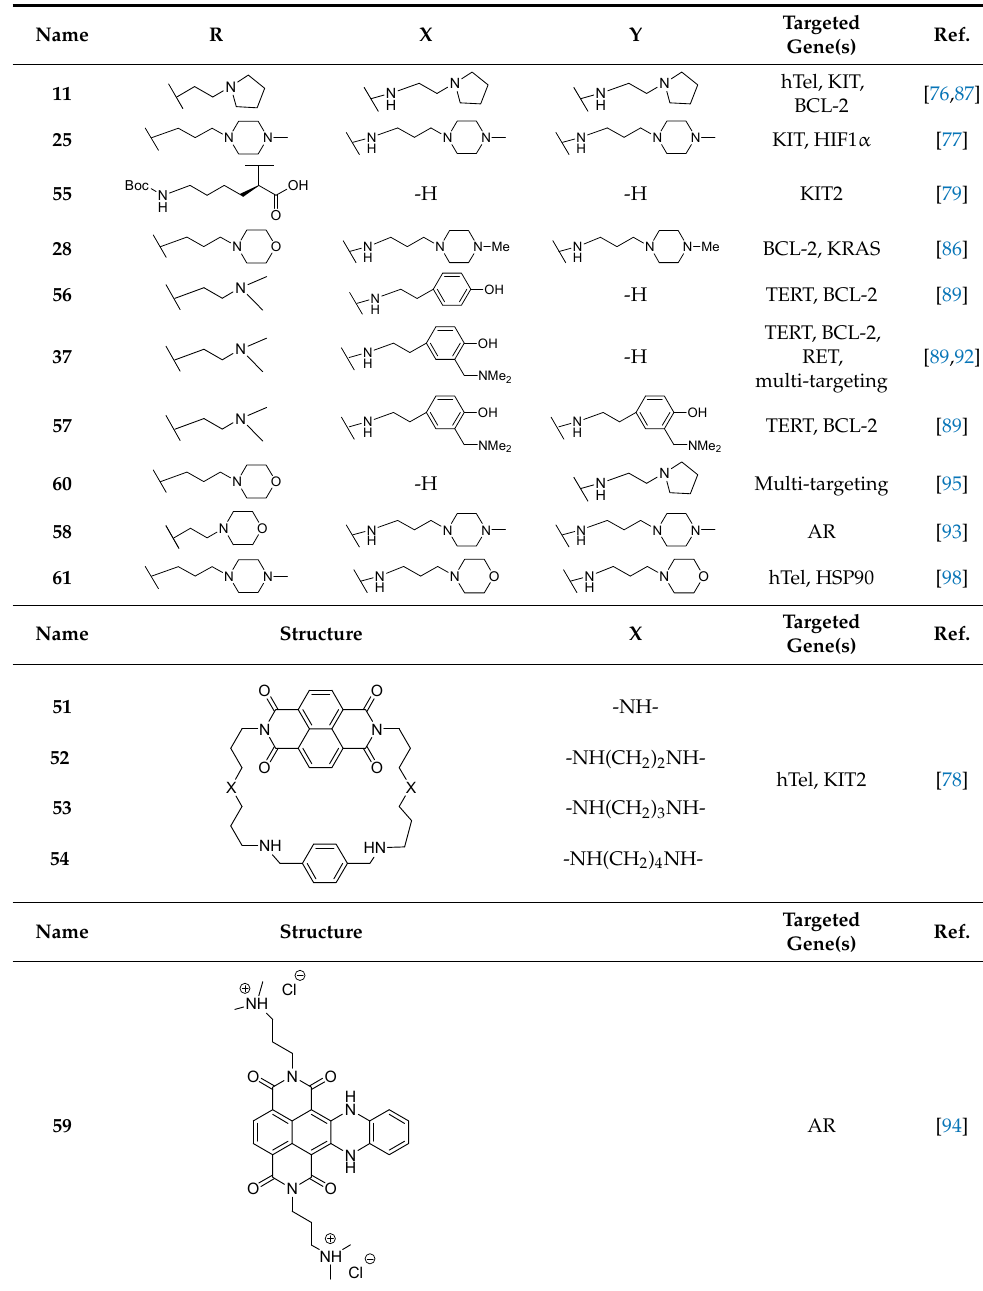
Table 4. In vitro and cellular data of NDIs used to target gene